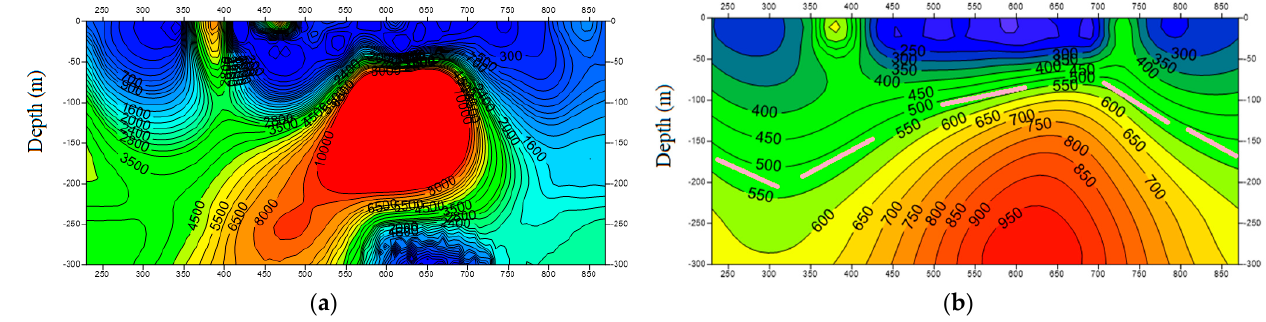
Figure 7. The resistivity sounding and pseudo-3D resistivity inversion results of the HJS-03 survey profile. ( a ) Resistivity sounding result. ( b ) Pseudo-3D resistivity result (the red lines represent fault and the pink lines segment layer the resistivity).